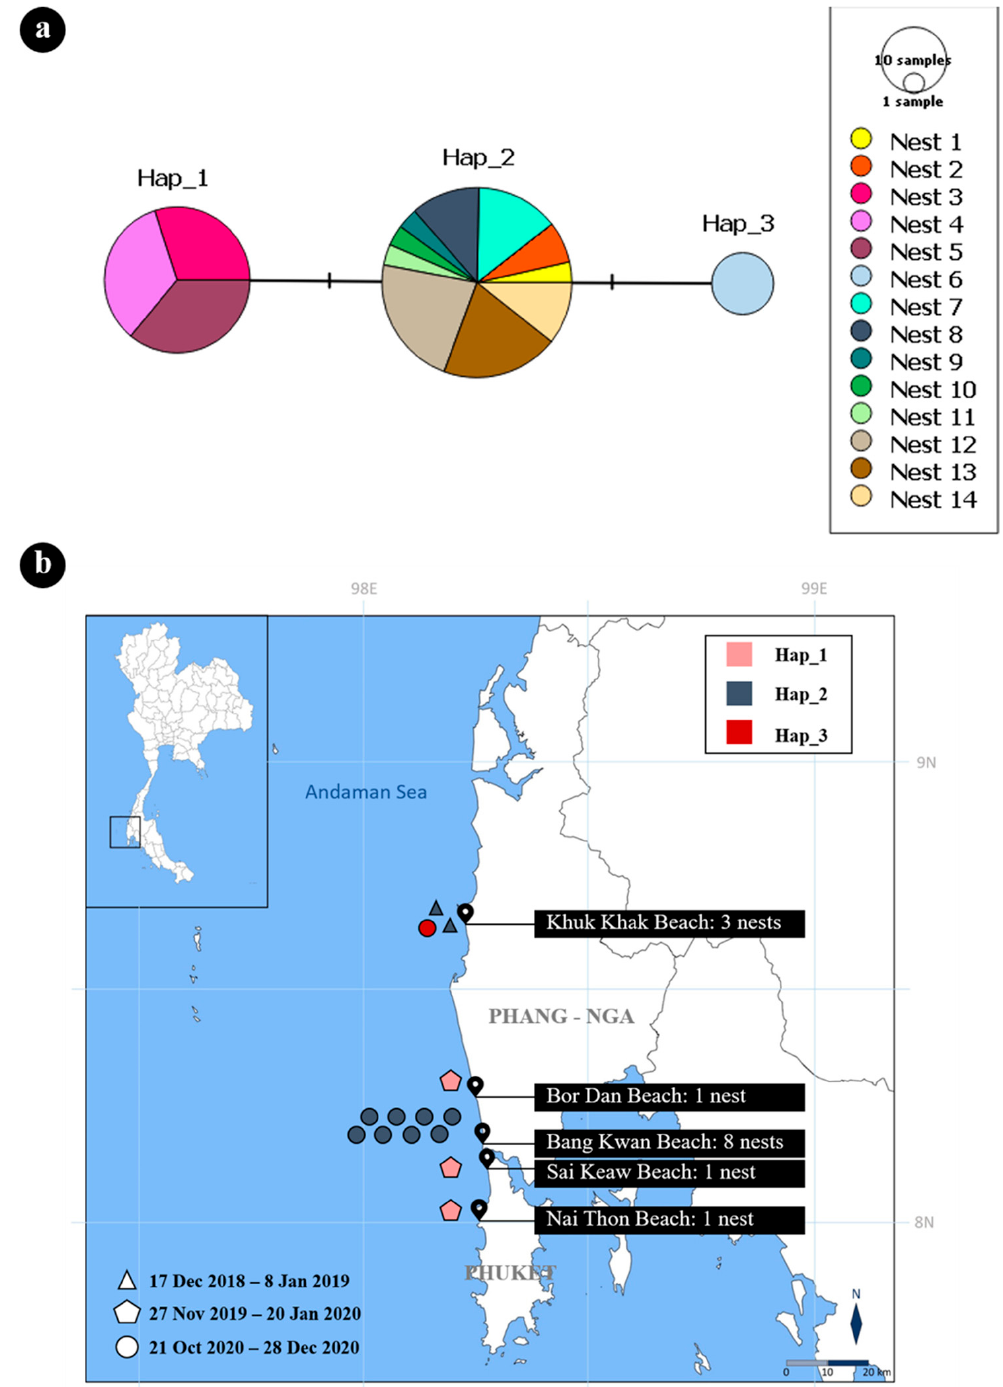
Figure 3. Haplotype of leatherback turtles in the Andaman Sea. ( a ) Median-joining network from analyses of the mtDNA control region of leatherback turtles in the Andaman Sea. Size of the circles are proportional to the haplotype frequencies. Number of mutations between haplotypes is illustrated by dashes in connecting lines; ( b ) Number of nests from five locations collected from two provinces in the Andaman Sea.